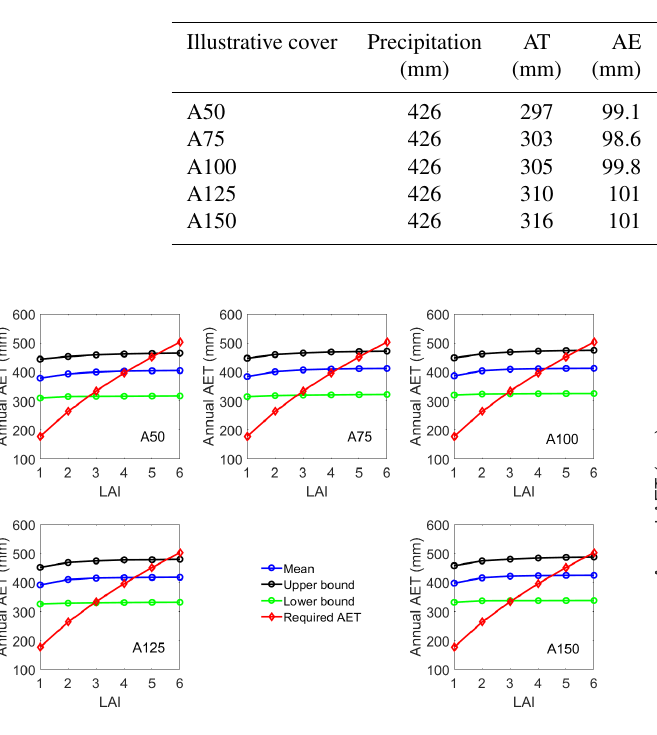
Figure 10. Lower (10%), mean, and upper (90%) limits of LAI_max values for the five illustrative covers showing variabil- ity in the LAI values based on the simulated annual AET with the 700 parameter sets over a 60-year climate cycle.